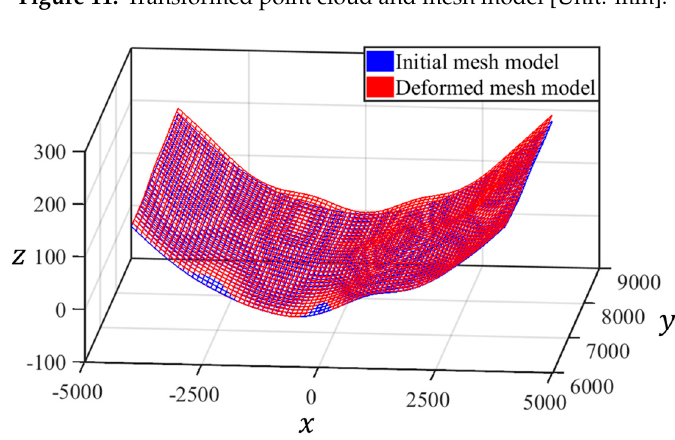
Figure 12. Mesh models of initial and deformed shape [Unit: mm ].